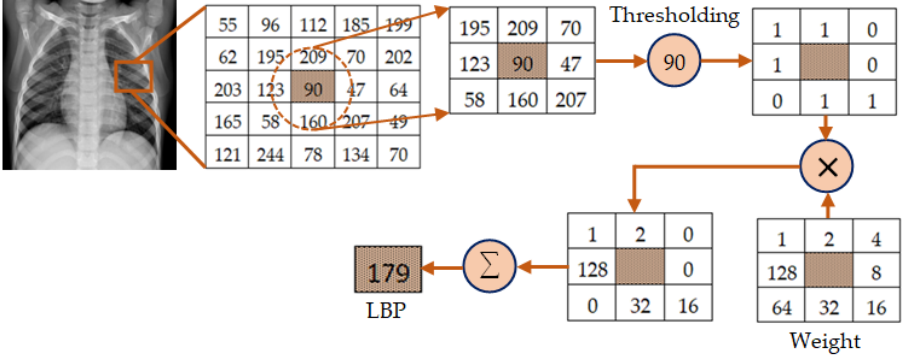
Figure 3. Illustration of the mechanism of feature extraction using LBP for P = 8 and R =